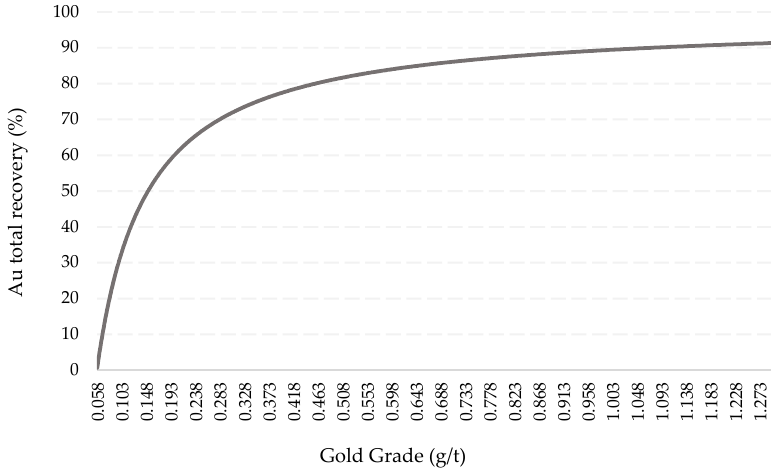
Figure 2. Gold recovery trend (total recovery) as a function of the gold content.